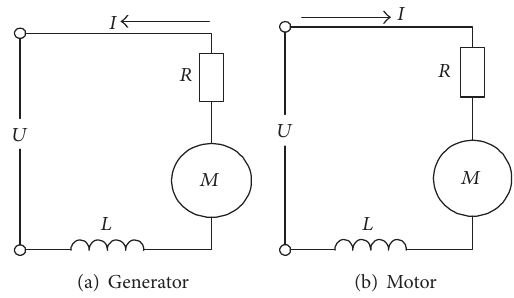
Figure 3: Schematics of the circuit